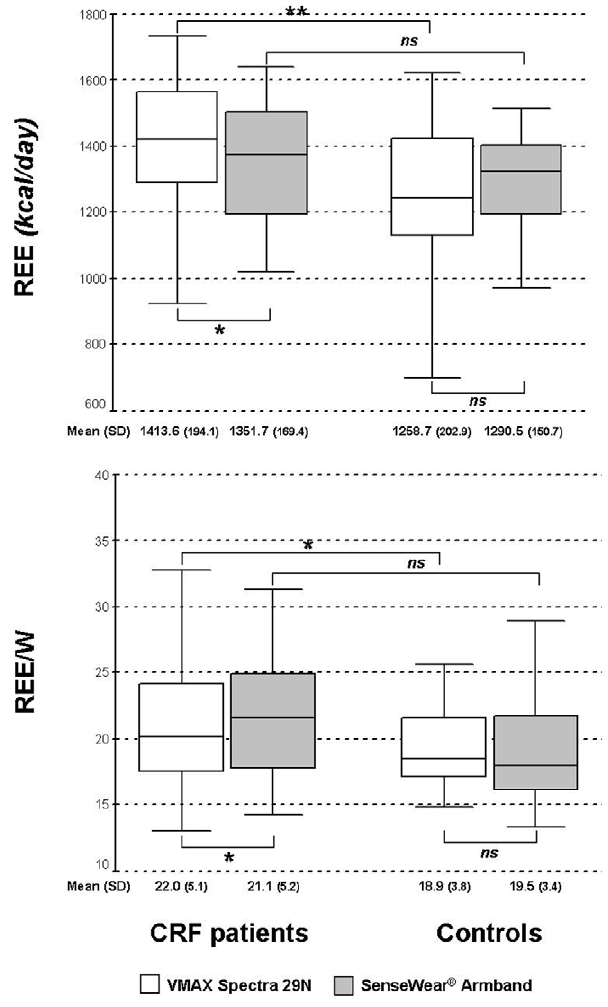
Figure 2. Comparison of REE and REE/W values obtained by indirect calorimetry and SWA in the two study groups (for details see Methods). *p , 0.05 , **p , 0.001 , ns: not significant .